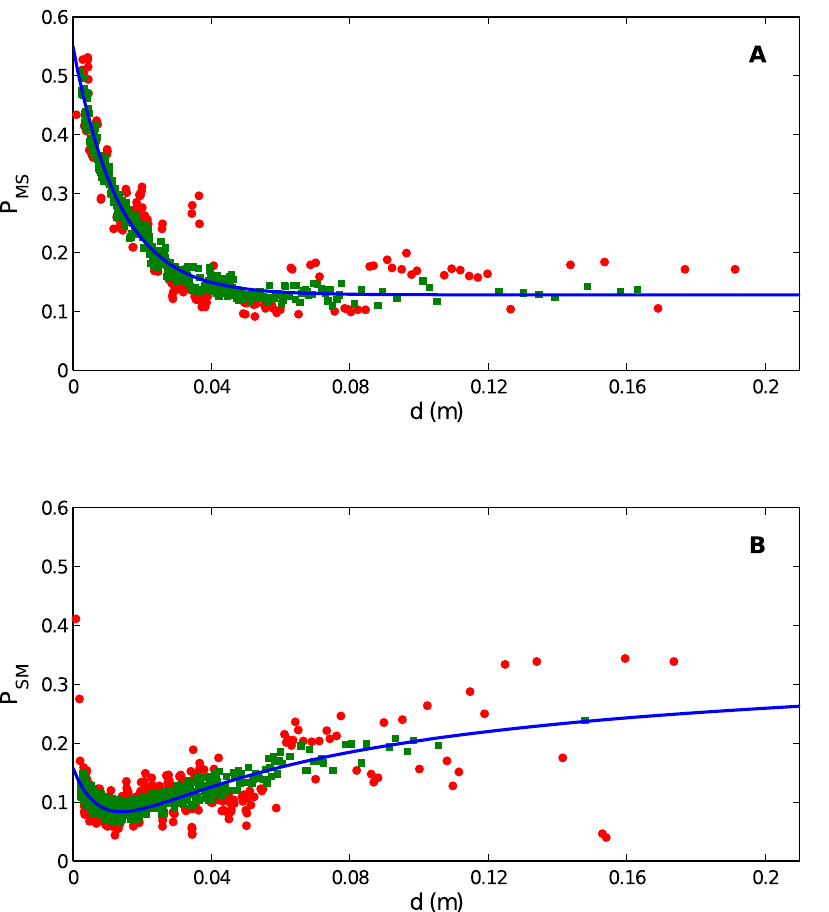
Figure 2. State transition probabilities P MS and P MS as a function of distance to an aphid’s nearest neighbor, d (in m ). (A) P MS , the probability that an aphid moving in a given timestep becomes stationary at the next timestep. Each data point represents the probability within a bin of 800 elements from our experimental data set, where the data are binned by d . The probability is calculated via a simple frequency count according to Eq. (1). The overall dependence of the data on d is modeled with Eq. (2), which describes an increased probability of an aphid settling if a neighbor is nearby. Best fit parameters appear in the text; the coefficient of determination is R 2 =0.92. To give a further sense of the efficacy of the fit, we display each point according to the standard error of the mean within the bin it represents. If the model curve passes within two standard errors of the estimated value, we show it as a green square; otherwise, it is a red dot. (B) Like (A), but for the probability P SM that a stationary aphid starts moving. The model is Eq. (4), describing higher aphid mobility at very short and very long d . Here, R 2 =0.52; see text for discussion.